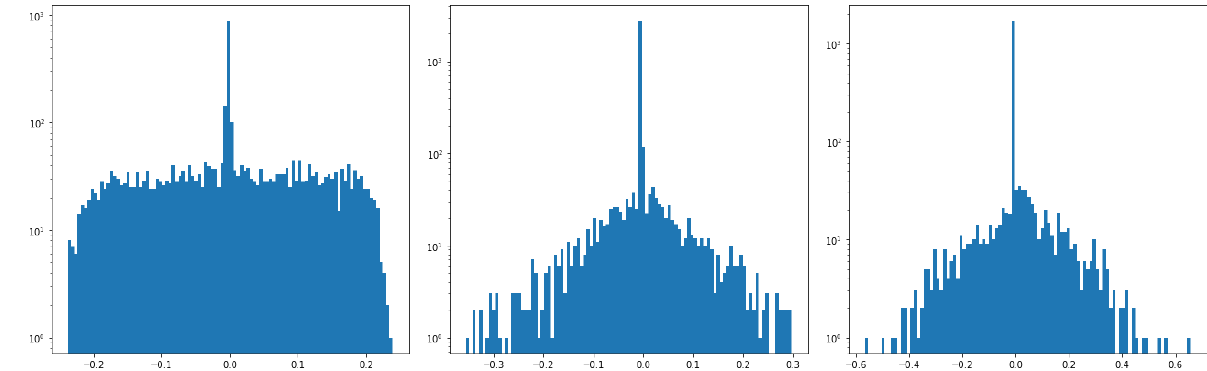
Figure 11. Histograms of weights for the first layer. From left to right: base network, quantized network and pruned network.